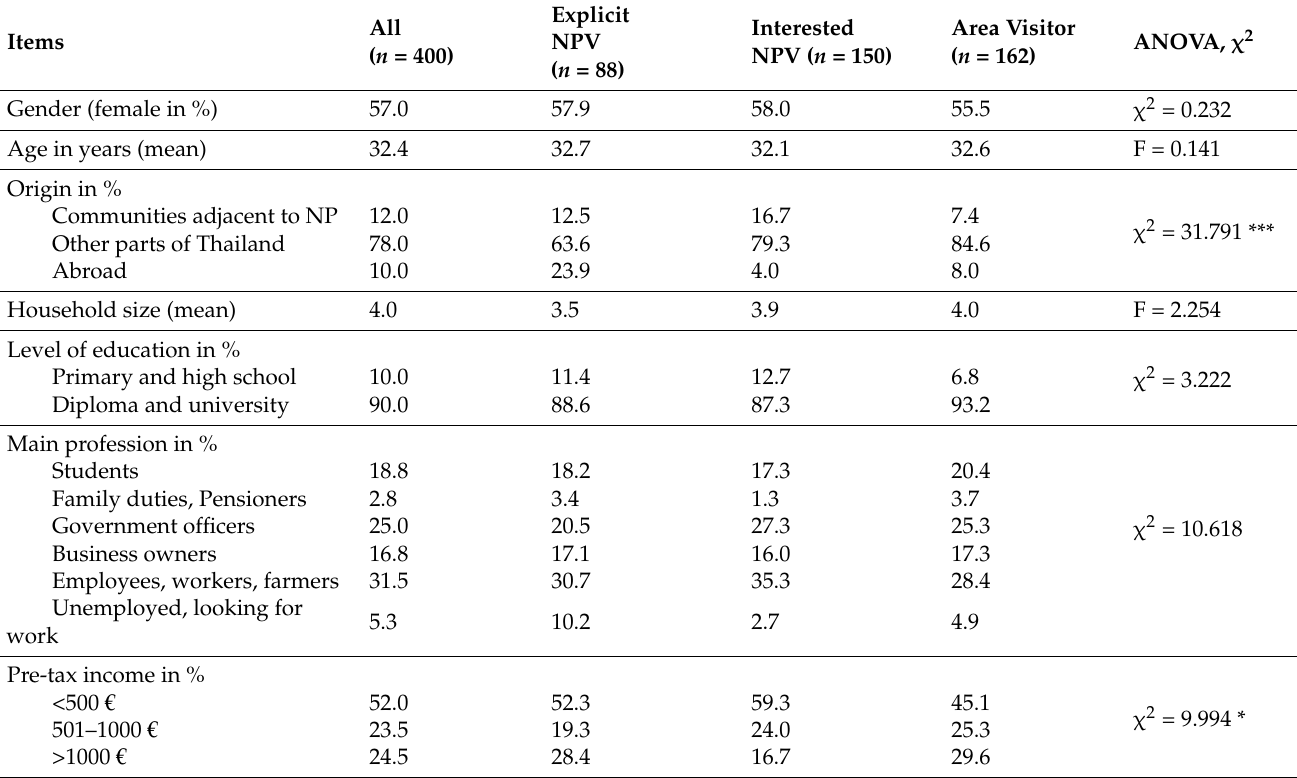
Table 2. Socio-demographic profile of respondents and per affinity segment ( n = 400).